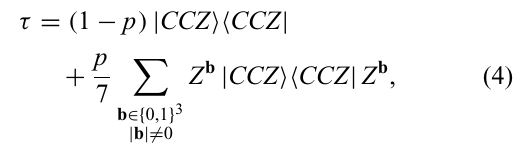
FIG. 1. (a) Steane’s code. Qubits are on vertices; X - and Z -type stabilizers are on faces. (b) A [[5,1,2]] code obtained by morphing (a) with R comprising the qubits in the red face, where the corresponding child code is a [[4,2,2]] code with logical qubits The stabilizer group of the [[5,1,2]] code is (cid:4) X 1 X 2 X ¯ gray qubits and CZ to the white qubits; H = H ⊗ 5 SWAP ¯ stabilizers are on cells and faces, respectively. (d) A [[10,1,2]] code obtained by morphing (c) with R comprising the qubits in the yellow cell, where the corresponding child code is an [[8,3,2]] code with logical qubits code is generated by X 1 X 2 X 4 X 5 X ¯ apply T ± 1 to the light and dark gray qubits and CCZ to the white